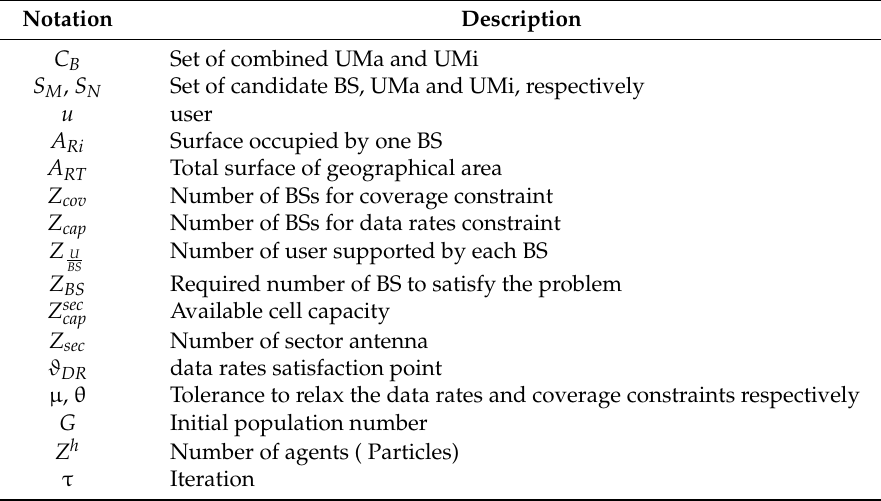
Table 1. Parameters notations and their corresponding